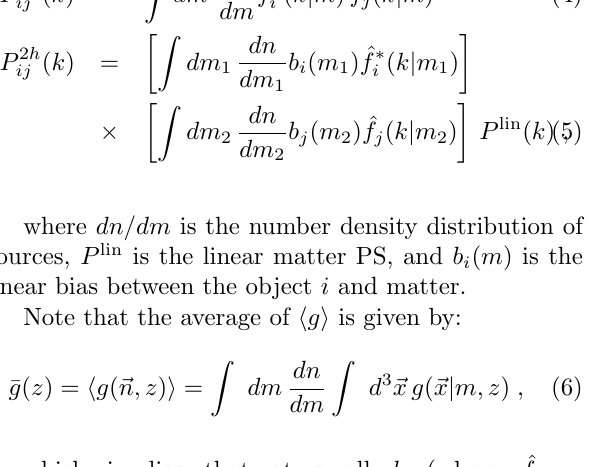
Figure 1: Left : EGB emission as a function of observed energy for the four extragalactic components described in the text. Data are from Abdo et al. (2010)a. Right: γ -ray angular PS at E > 1 GeV for the same models of the left panel. The observed angular PS is summarized by the black band from Ackermann et al. (2012). This figure is taken from Camera et al. (2012).